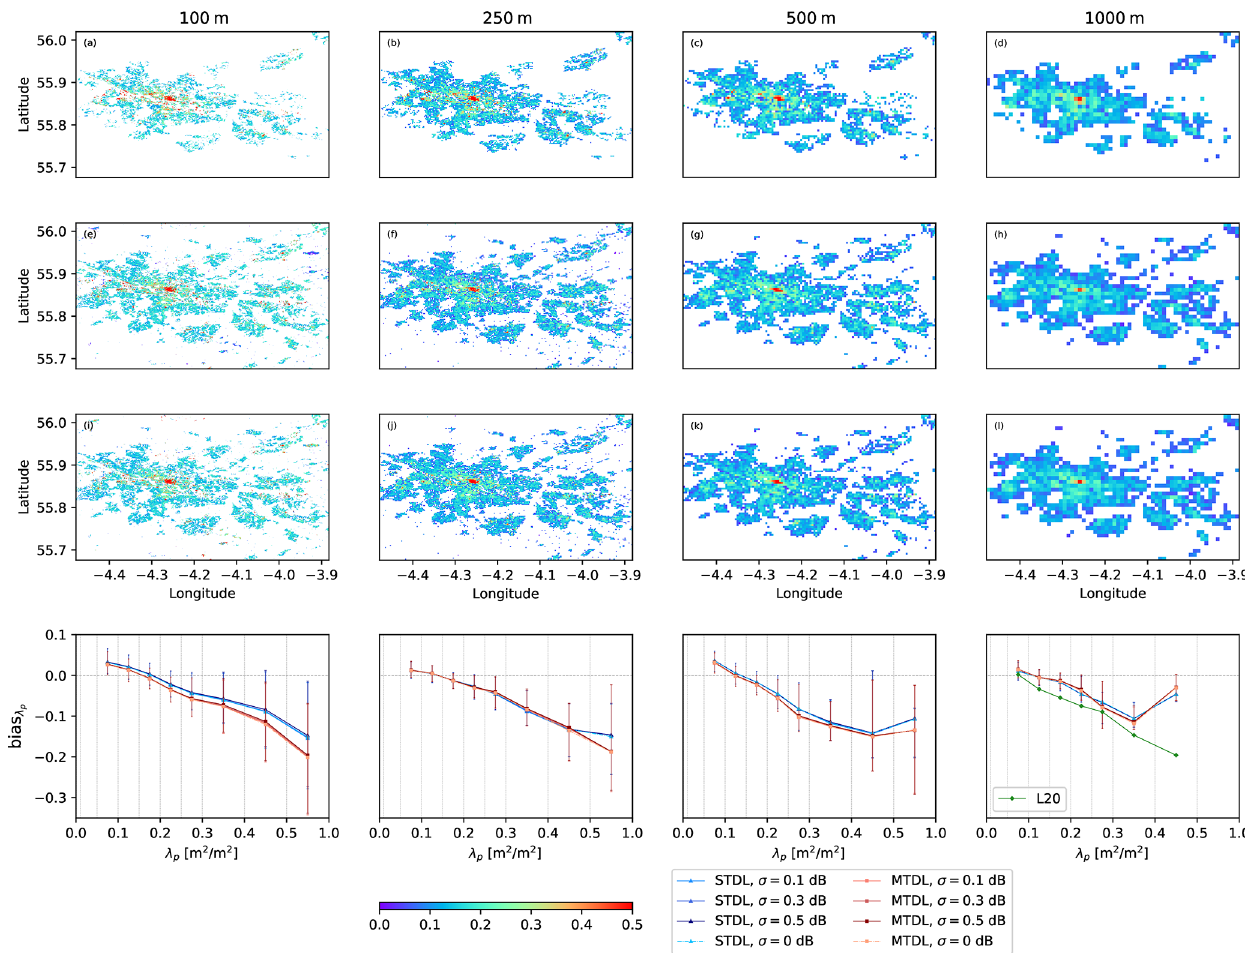
Figure 17. Same as Fig. 16, but for building footprint and corresponding target domains are divided by 0.001, 0.01, 0.05, 0.1, 0.15, 0.20, 0.25, 0.3, 0.4 and